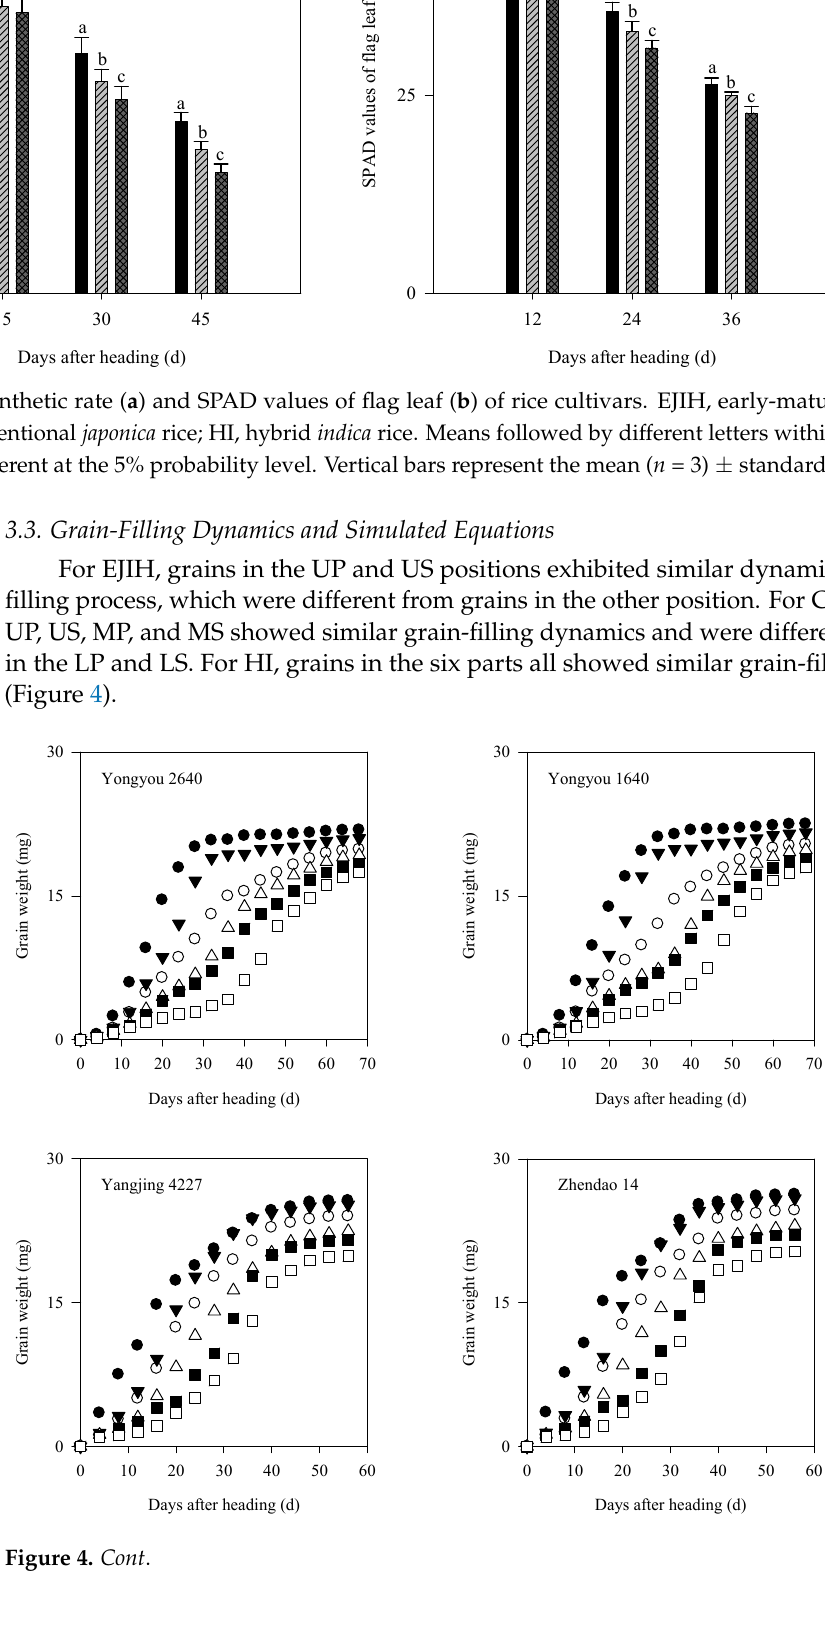
Figure 4. Dynamics in grain − fi lling process of Yongyou 2640 ( a ), Yongyou 1640 ( b ), Yangjing 4227 ( c ), Zhendao 14 ( d ), Fengyou 293 ( e ), and Zhongnanyou 1 ( d ). UP, upper primary branches; US, upper secondary branches; MP, middle pri- mary branches; MS, middle secondary branches; LP, lower primary branches; LS, lower secondary branches.